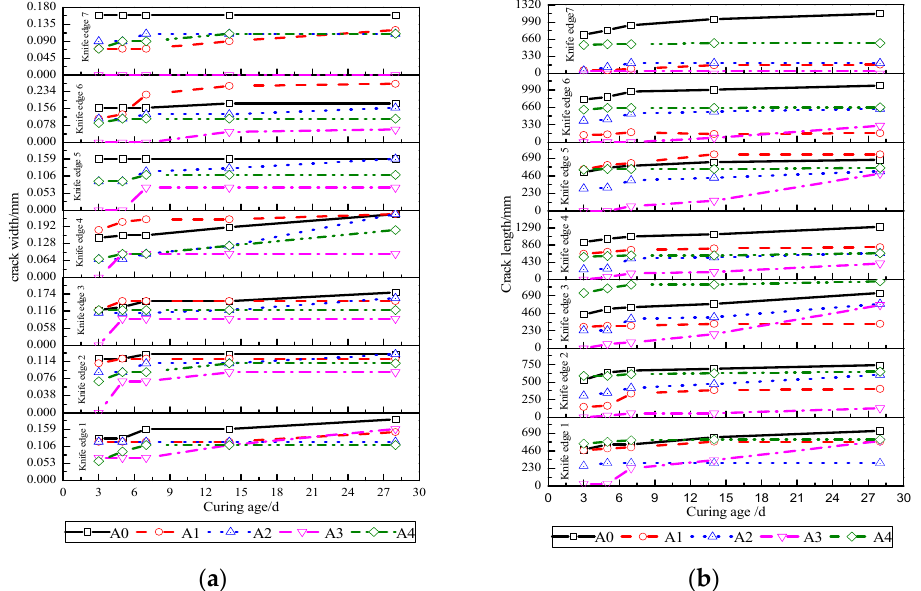
Figure 10. The relationship between crack width and length of cracks at each flat knife-edge and age. ( a ) Crack width; ( b ) Crack length.